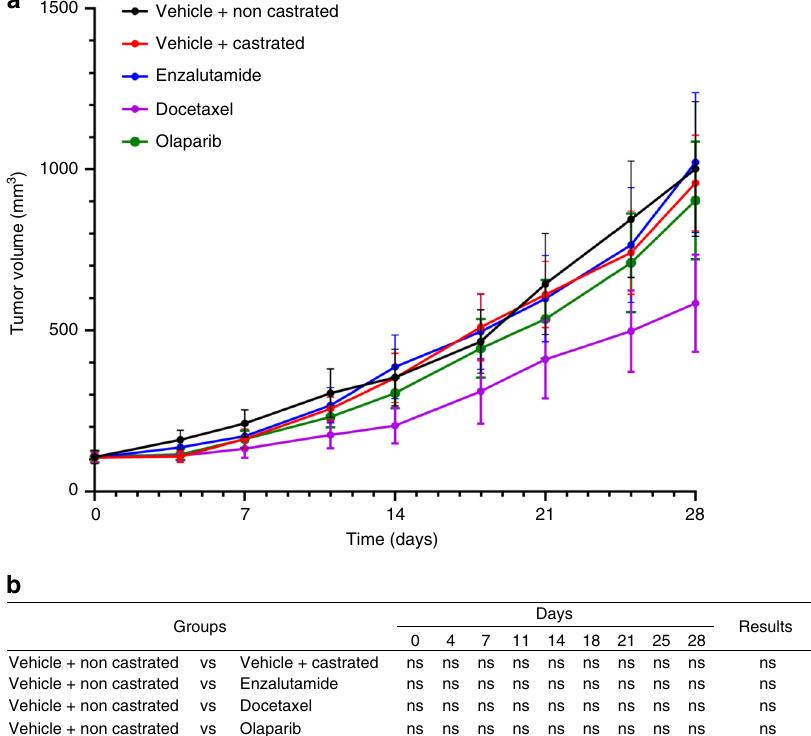
Fig. 8 In vivo drug assays. a The CDX is resistant to docetaxel, enzalutamide, and olaparib. Non-castrated mice bearing passage-8 CDX tumors were treated with docetaxel, enzalutamide, olaparib, or the vehicle. Control surgically castrated mice bearing CDX tumors treated by the vehicle were included. In each group n = 7. Tumor volumes of vehicle and treated groups over time after randomization are shown. Data represent mean tumor volumes ± s.e.m. b Comparison of the tumor volumes of vehicle and treated groups over time. A Mann – Whitney test has been applied for statistical